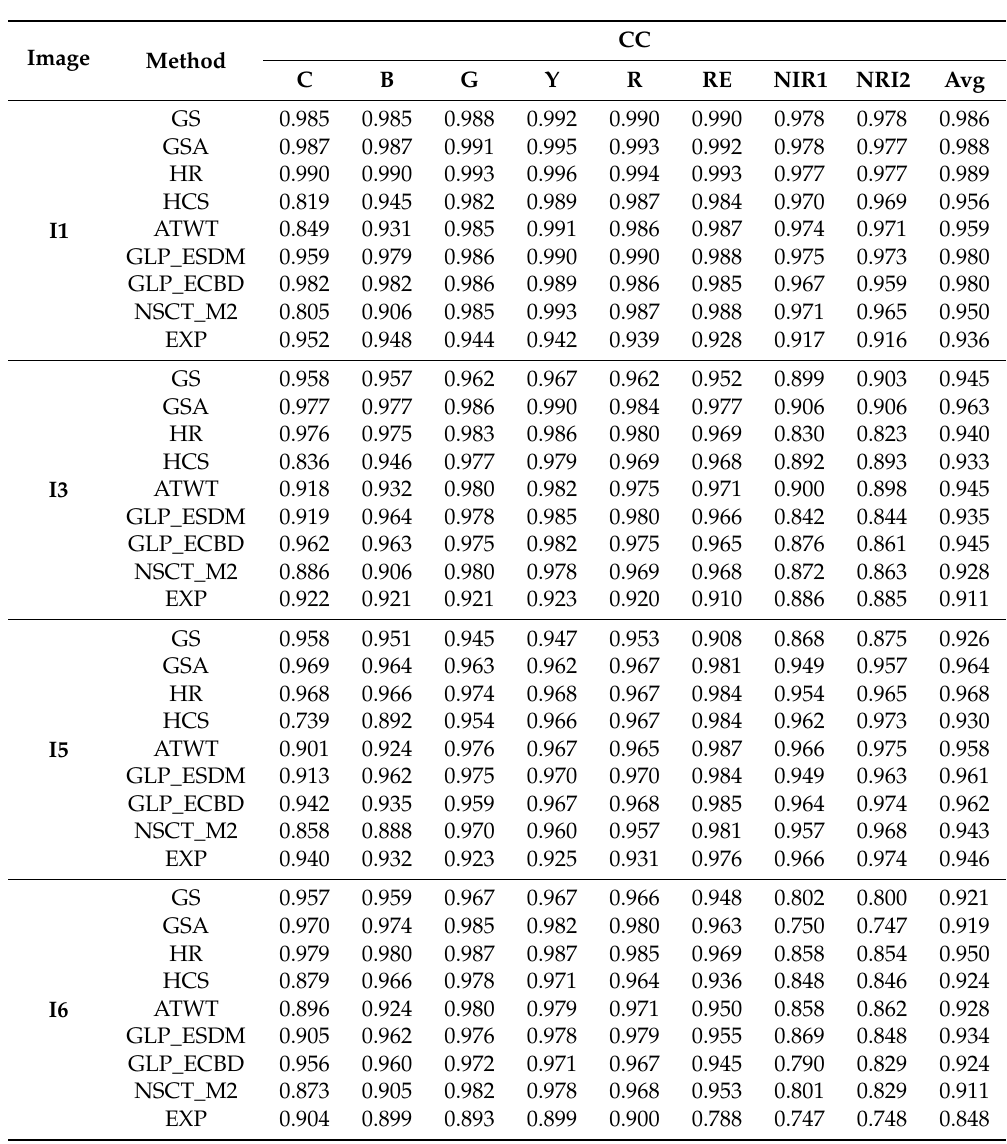
Table 6. The CC values for the fused bands for I1, I3, I5 and